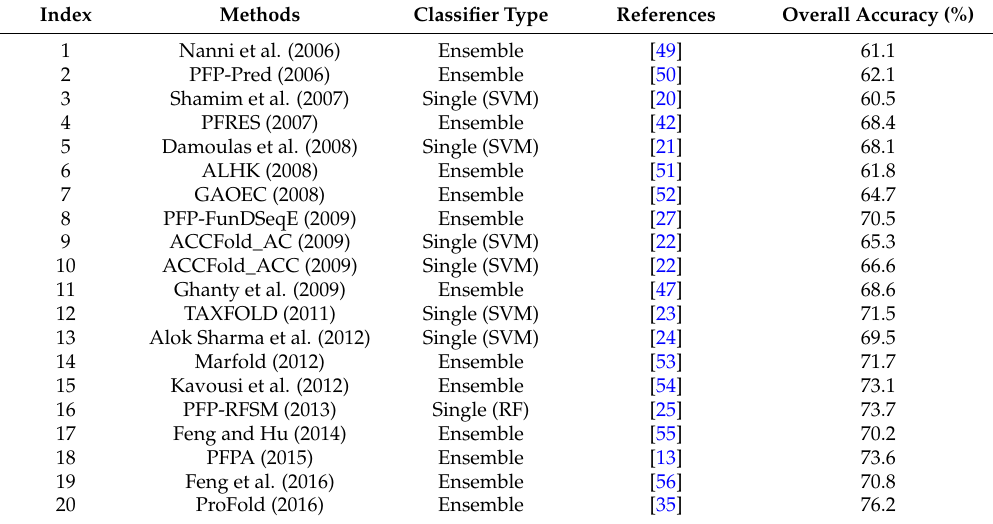
Table 3. Performance of representative machine learning-based methods in the literature on the DD